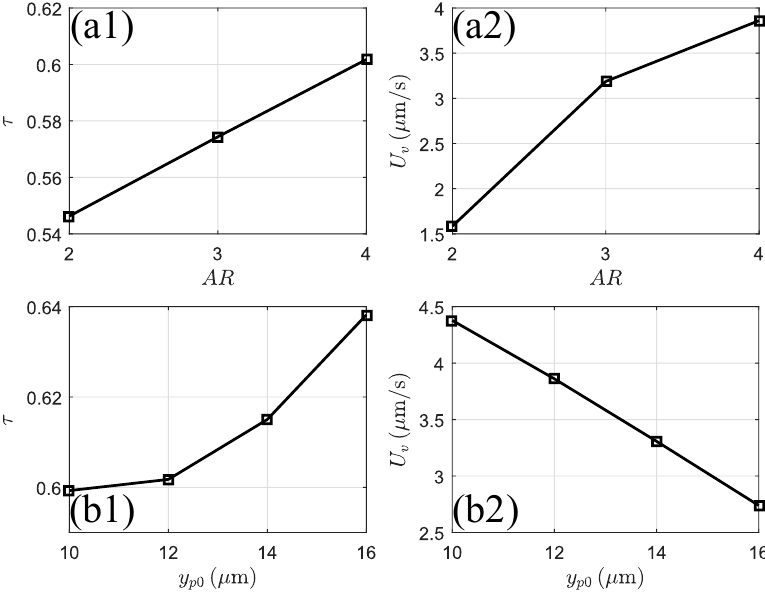
Figure 12. Dependence of ( a1 ) τ and ( a2 ) U v on particle aspect ratio AR , with the particle is initially located at y p 0 = 12 µ m. Dependence of ( b1 ) τ and ( b2 ) U v on initial particle–wall separation distances y p 0 when the particle aspect ratio is AR = 4. The magnetic field strength H 0 = 2000 A/m is applied at α = 0 ◦